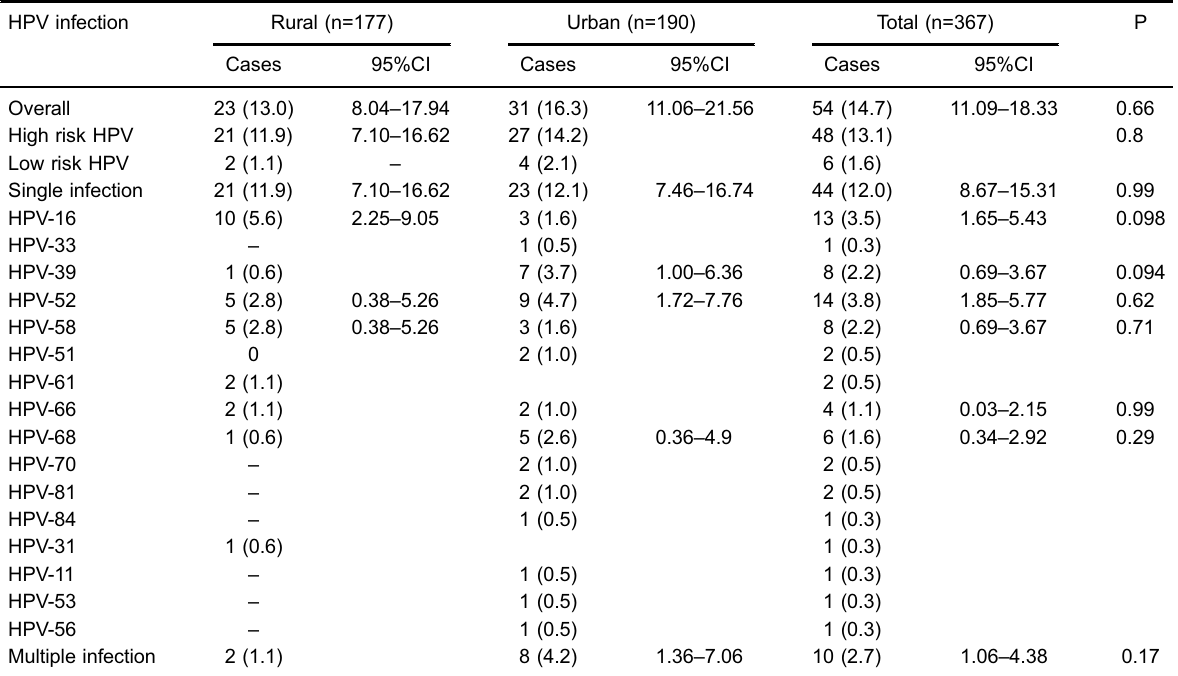
Table 1. HPV prevalence and genotype distribution among samples from rural and urban populations in China. HPV